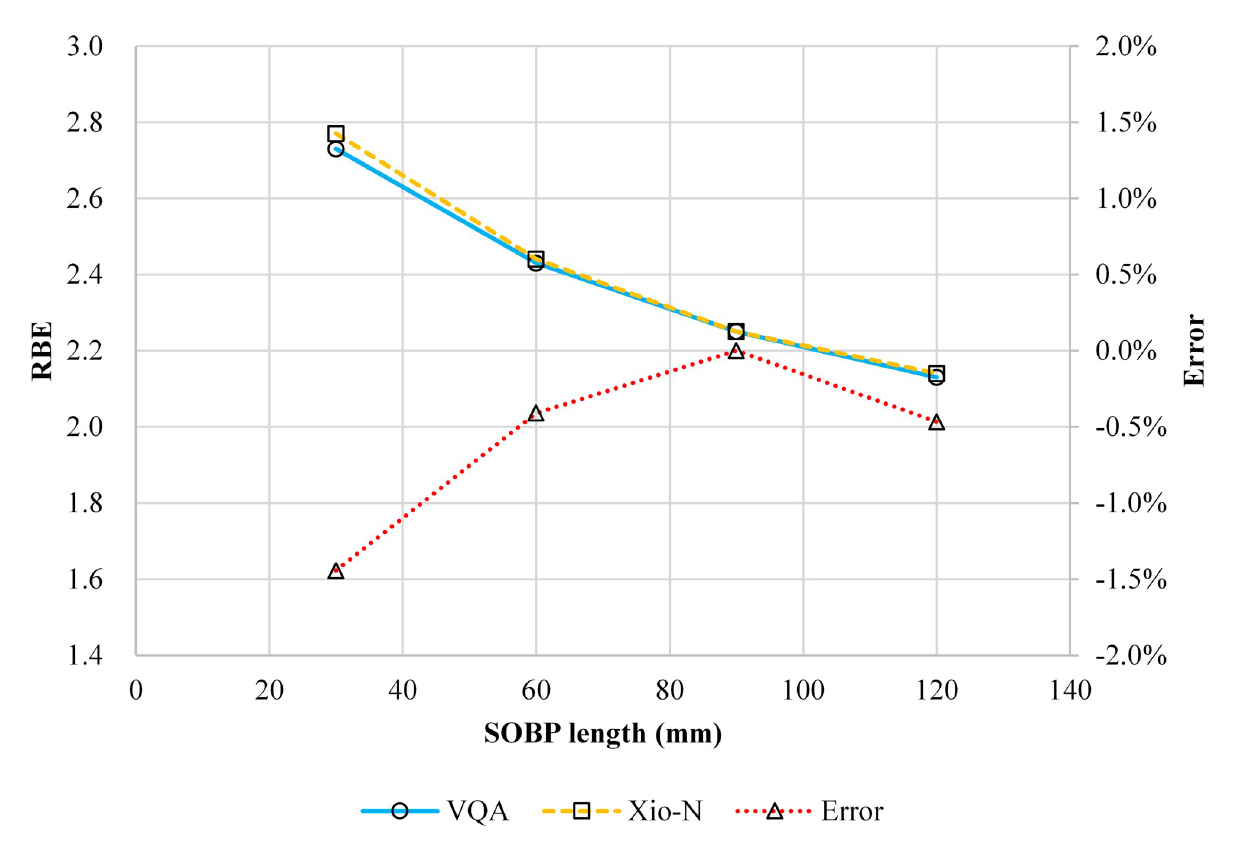
Fig 10. RBE for the selected volumetric dose distribution of CIBs with a field size of 60 × 60 mm 2 and a range of 150 mm as a function of SOBP size from 30 to 120 mm. The RBE values calculated using VQA Plan and Xio-N and the difference between the two are shown as a solid line with circles, dashed line with squares, and dotted line with triangles,